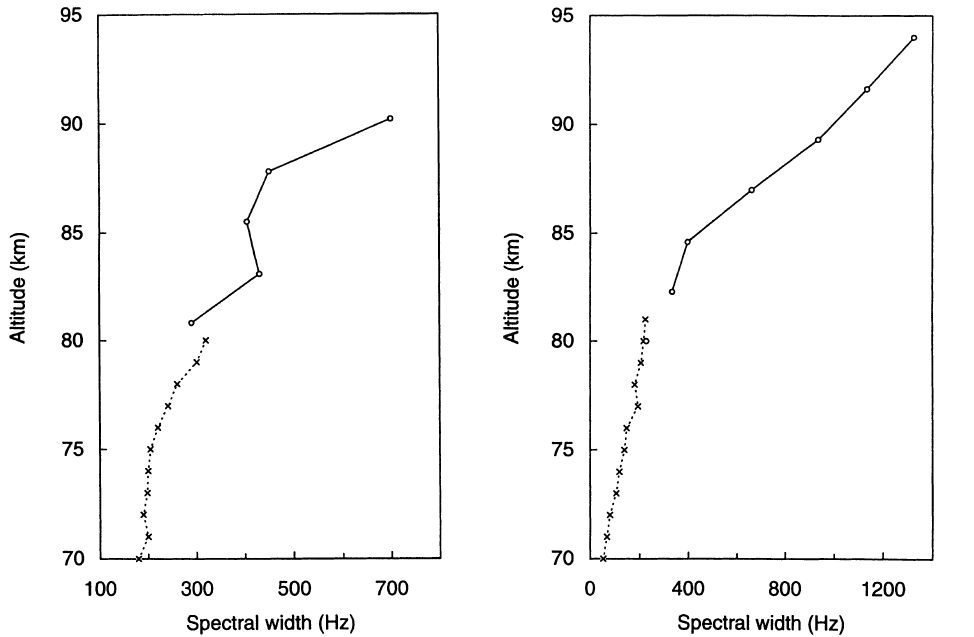
Fig. 9. Synthesis of spectral width measurements at UHF during PCA events from multipulse (o) and pulse-to-pulse (–x–) observations on the same day. Left: 23 October 1989, 1530 UT (x) and 1803 UT (o). Right: 1 December 1989, 1910 UT (x) and 0917 UT